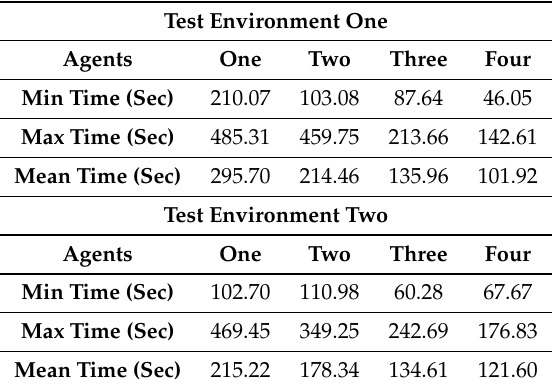
Table 6. Framework Test Results.